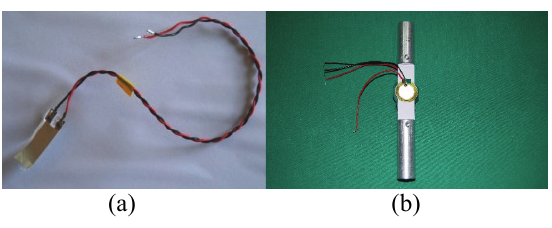
Fig. 3. The aspect of the power generation object, (a)